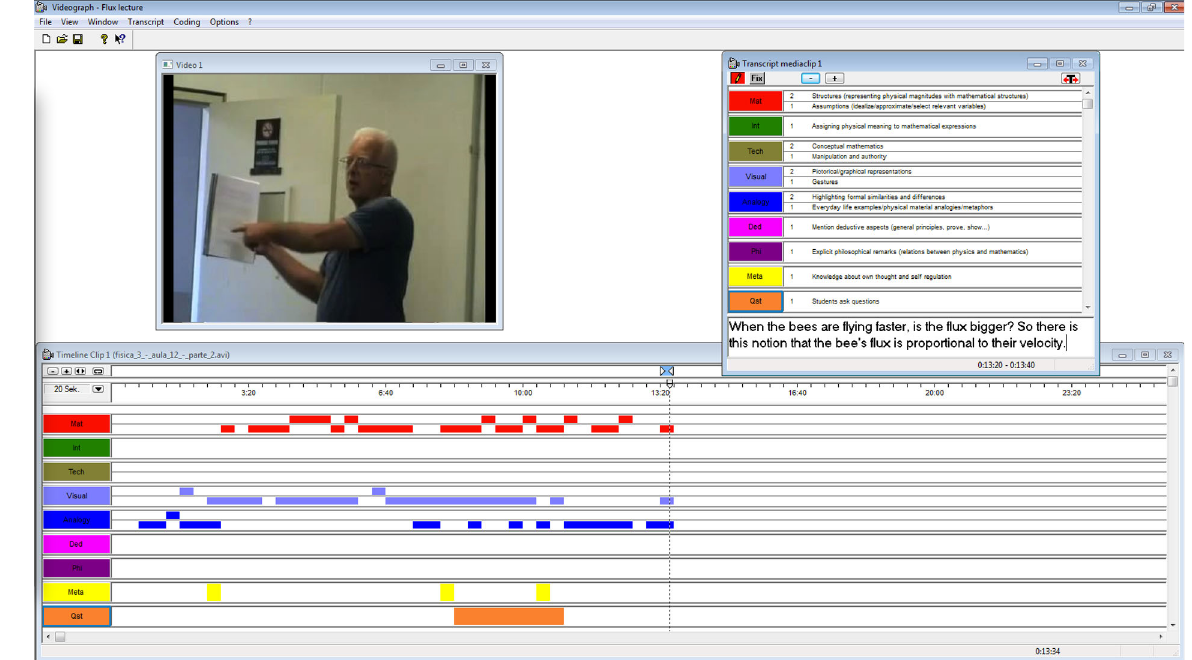
FIG. 1. Videograph ’ s coding